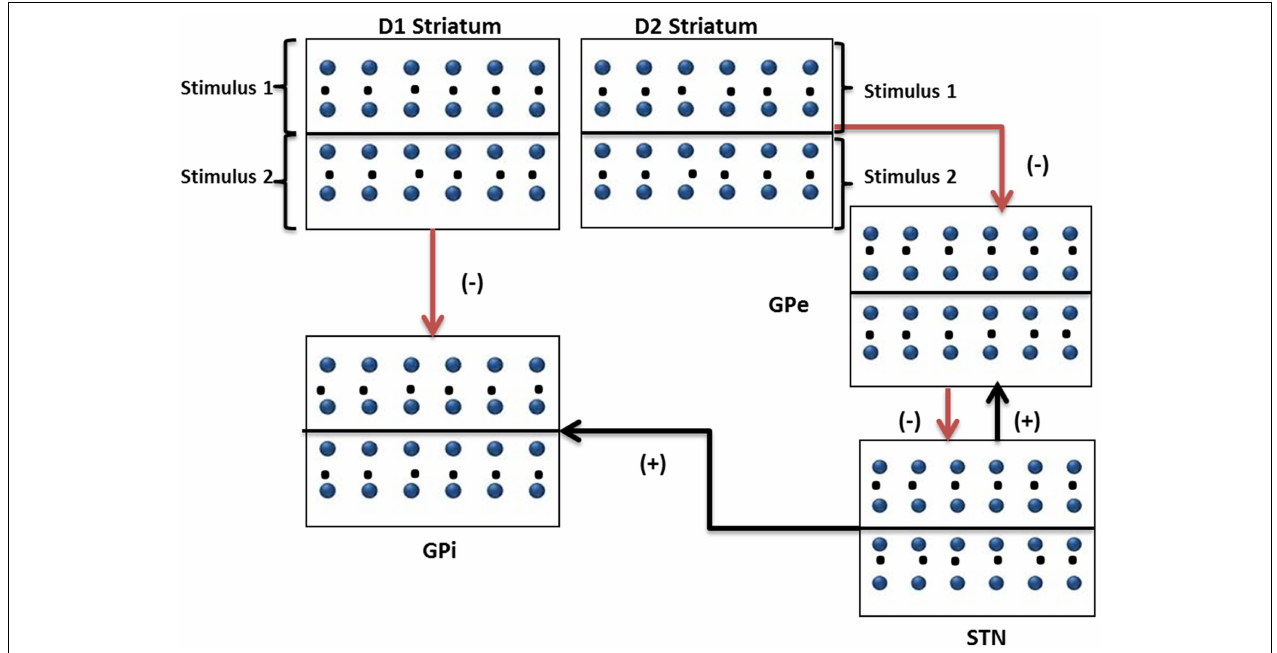
FIGURE 2 | Modeling the binary action selection task. The figure shows a pictorial representation of inputs to striatal, GPi, GPe, and STN networks (50 * 50) depicting D1 and D2 neuronal pools and their projections to GPi and GPe networks. Stimulus #1 and Stimulus #2 are the inputs with frequencies representing saliency.